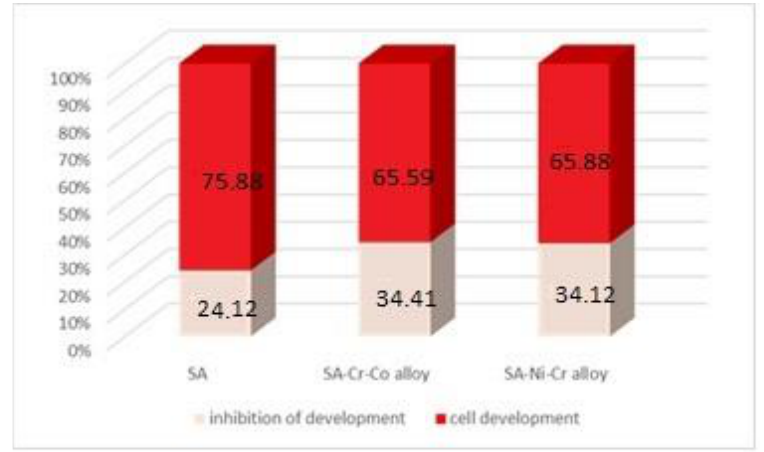
Figure 11. Alteration of the developmental process of monkey kidney cell cultures. The degree of cell development was reduced compared to the control group, with values between 34.12% and 40%, when the ionic diffuses from the incubation of the sam- ple made of Ni-Cr alloy and Cr-Co alloy were present in the culture media renal cells. cell growth inhibition by the dental materials alone was 10% (Ni-Cr alloy) and 10.29% for Cr-Co alloy.